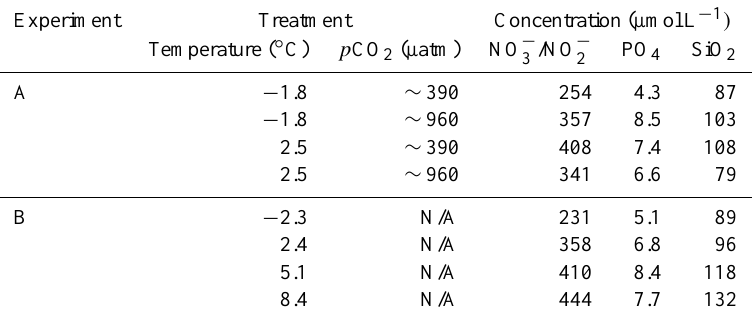
Table 3. Inorganic nutrient concentration after 14 days in Experiment A and